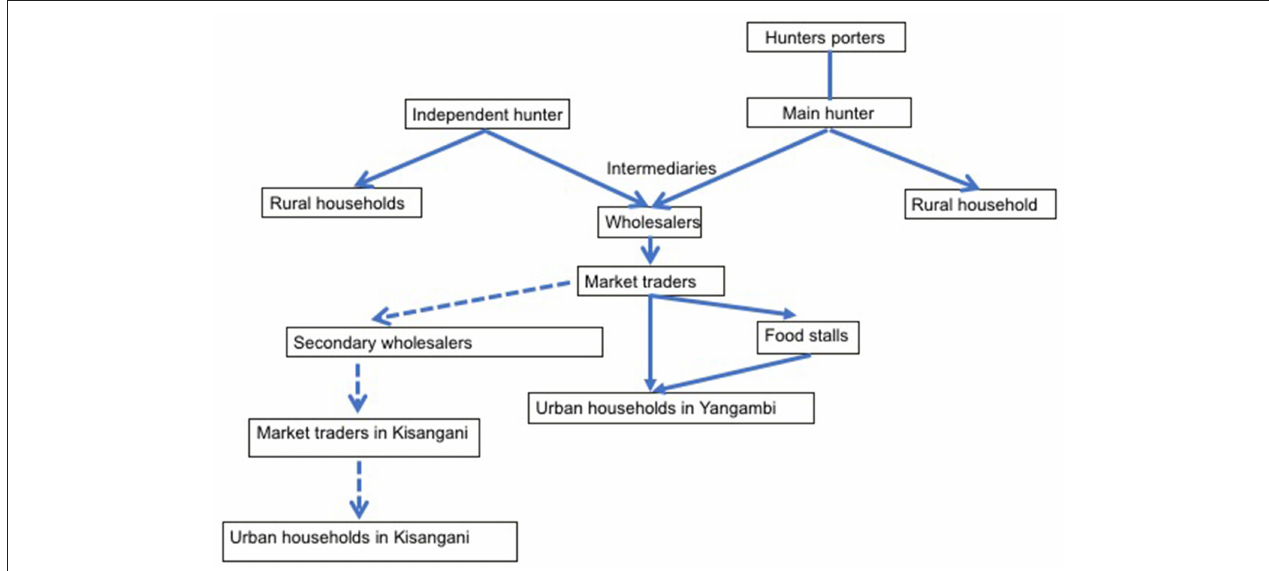
FIGURE 2 | Structure of the trade chain and relationship between stakeholders involved in the trade of wildmeat.